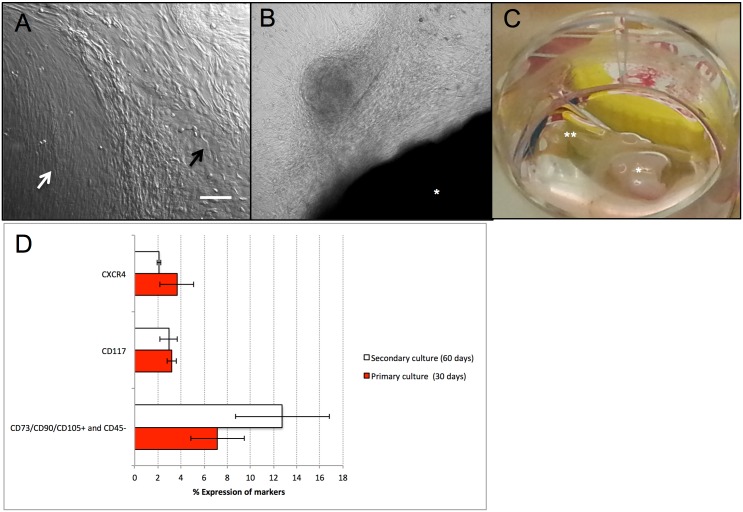
Morphological and flow cytometry profile results of prolonged limbal explant cultures cultivated without amniotic membrane.Limbal explant outgrowth of cells cultured on plastic culture plates in the absence of feeder layer cells and in medium supplemented with only human serum showed after 3 weeks of culture two morphologically distinct cell population types, a predominantly epithelial-like (black arrow) and a more fibroblast-like cell population (white arrow) (A). A sphere-shaped formation with spindle shaped cells around it was observed (B). (A,B: Magnification:4x). A limbal explant culture after 2 months of culturing without any passaging showing a translucent corneal stromal-like 3D tissue (C) (the total time of observation in culture was 6 months). A plot representing the mean percentages ± SEM (n = 7, paired two-sample t-test) of flow cytometry profiles, red bars representing the primary limbal cultures and white bars the transfered secondary limbal cultures, the differences not being statistically significant (p > 0.05) (D). (*) means limbal explant; (**) means translucent tissue. Bar, 100 μm.